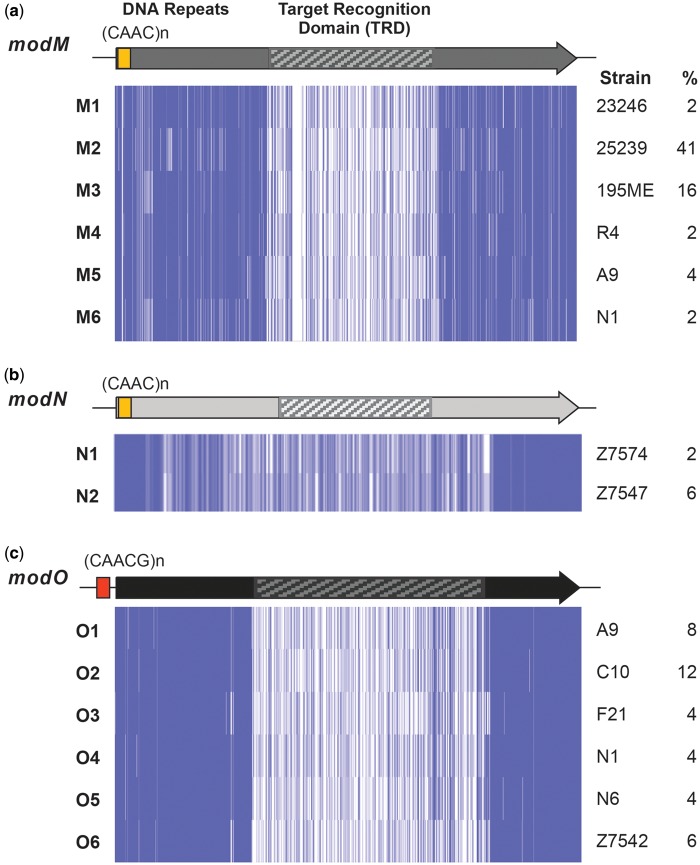
—Schematic of genes encoding phase-variable Type III DNA methyltransferases. (a) modM, (b) modN, and (c) modO. Type III DNA methyltransferase alleles (modM1-6, modN1-2, modO1-6) were aligned in ClustalW and visualized with JalView. Identical nucleotides are shown as vertical lines, with identity over a run of nucleotides shown as dark purple (>80% identity), light purple (>50%), or white (<50% identity or a gap). Moraxella catarrhalis representative strains that define each methyltransferase allele are indicated to the right of the alignment. Alleles were classified on the basis of ≥95% nucleotide identity of the target recognition domain (TRD) to one of these sequences. The proportion of strains (%) containing each methyltransferase allele in the 51 publicly available M. catarrhalis genomes is indicated on the far right. The locations of the 5′-(CAAC)n-3 repeats in the open reading frame (ORF) of modM and modN, and the 5′-(CAACG)n-3 repeat region upstream of the modO ORF, are indicated.